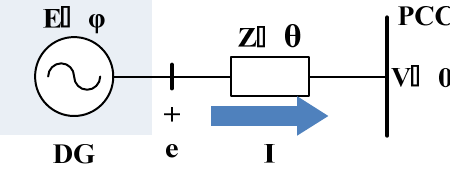
Figure 1. Equivalent circuit for distributed generation (DG) connected to an AC grid.